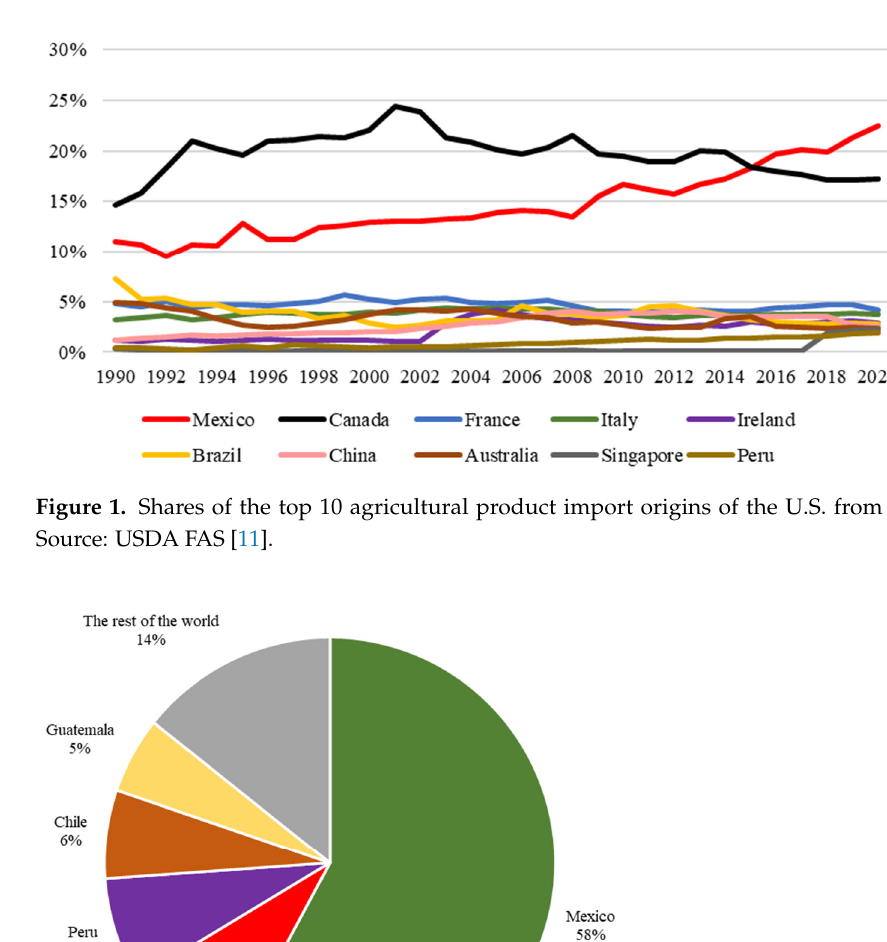
Figure 1. Shares of the top 10 agricultural product import origins of the U.S. from 1990 to 2020. Source: USDA FAS [11] .